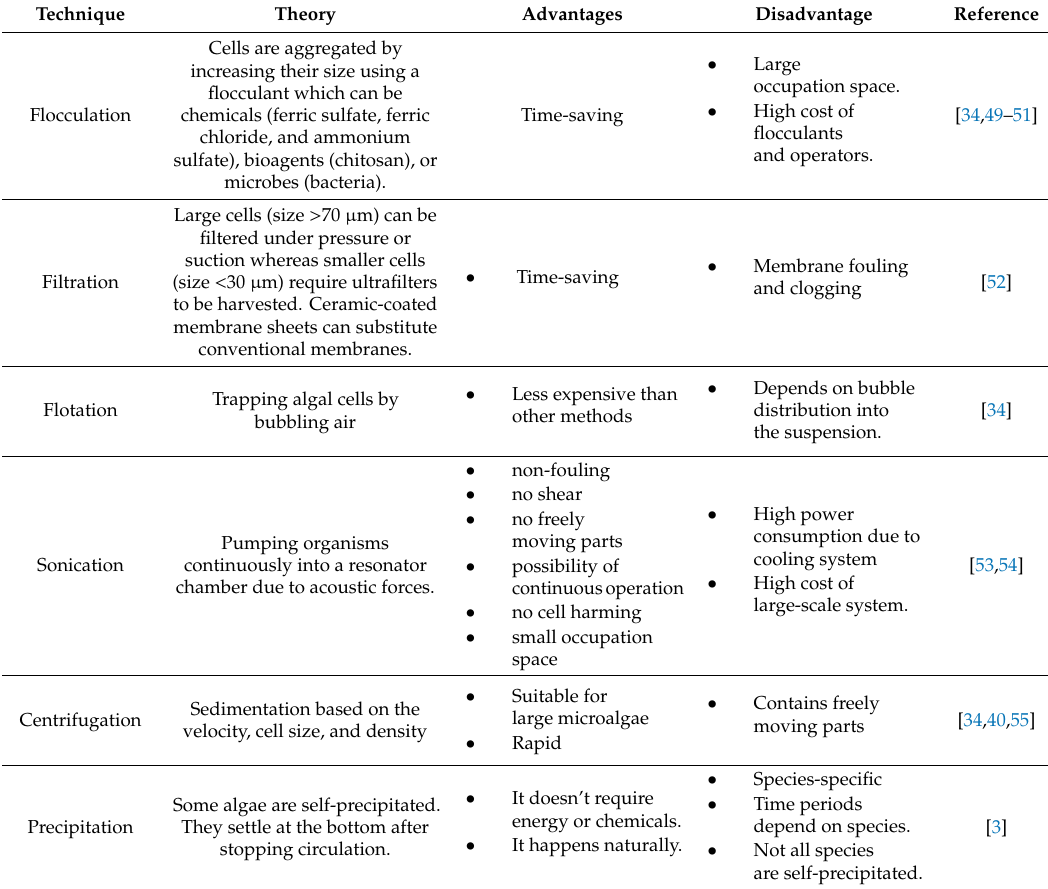
Table 2. Comparison of theory, advantages and disadvantages of algal harvesting methods.